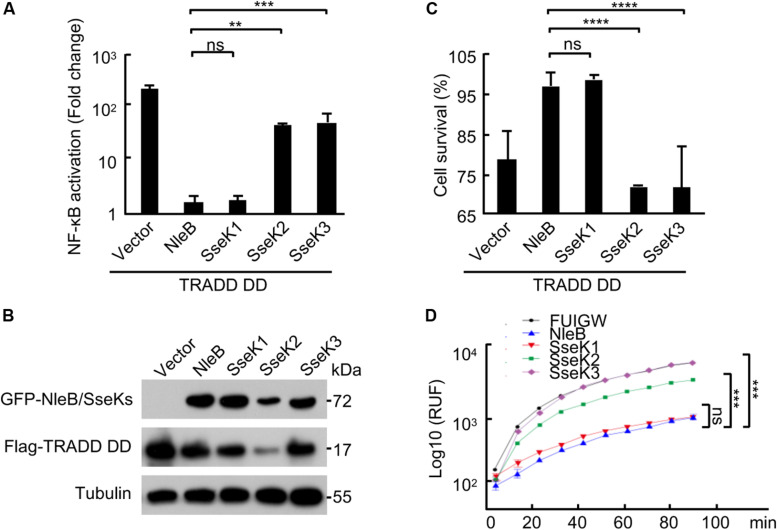
SseK1 inhibits TRADD-activated NF-κB and cell death signaling. (A–D) Effects of NleB/SseK on TRADD DD-activated NF-κB (A,B), cell survival (C), and caspase-3 activation (D). 293T cells were transfected with Flag-TRADD DD in combination with the indicated plasmids. NF-κB luciferase activation was indicated as fold change (A). Cell viability was determined by measuring ATP levels (C). Caspase-3 activity was assayed using an Ac-DEVD-AFC probe according to manufacturer’s instructions (D). For A and C, one-way ANOVA was used for statistical analysis. And for D, two-way ANOVA was used. **P < 0.01, ***P < 0.001, ****P < 0.0001, ns, not statistically significant. All data are acquired at the same time and at least three independent experiments.